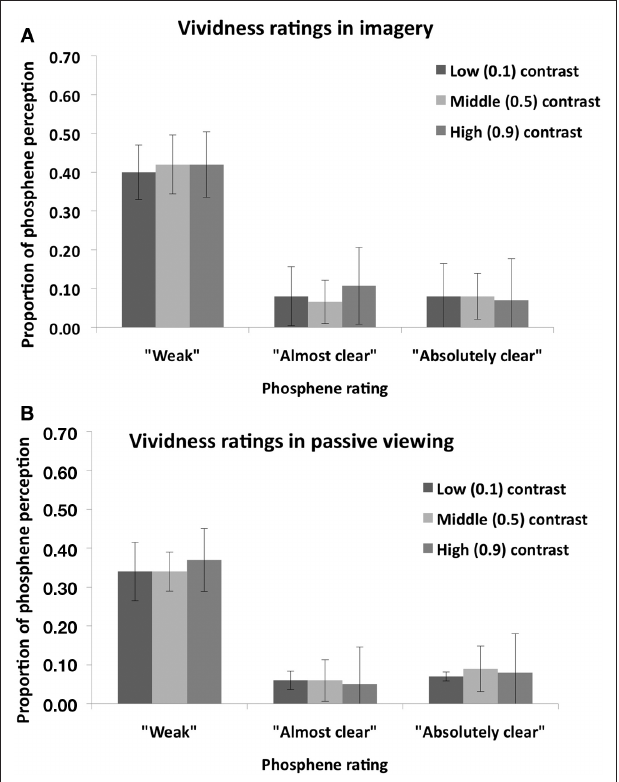
Figure 3 | Mean ( n = 8) vividness rating for perceived phosphenes in the “Visual imagery condition” (A) and in the “Passive viewing” condition (B) of experiment 1. Error bars represent ± 1 SEM.